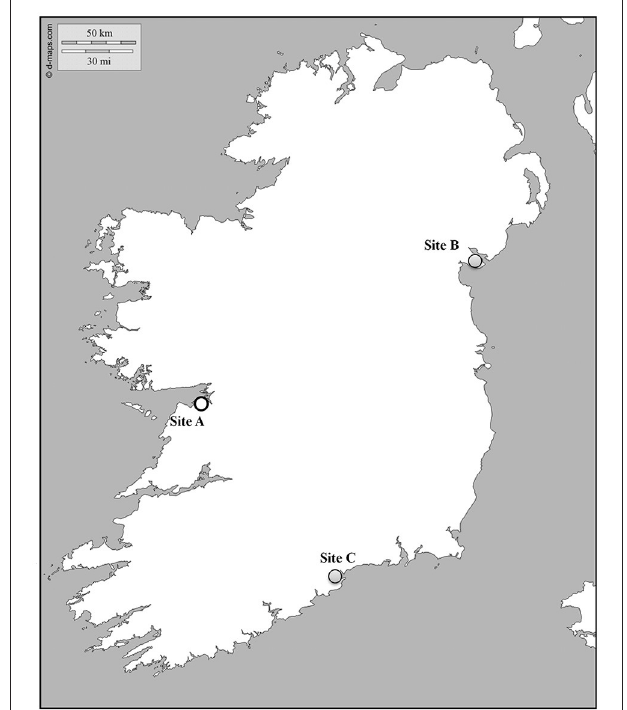
FIGURE 1 | Map showing the location of the sampling sites. Gray and white dots indicate infected and virus free areas, respectively.